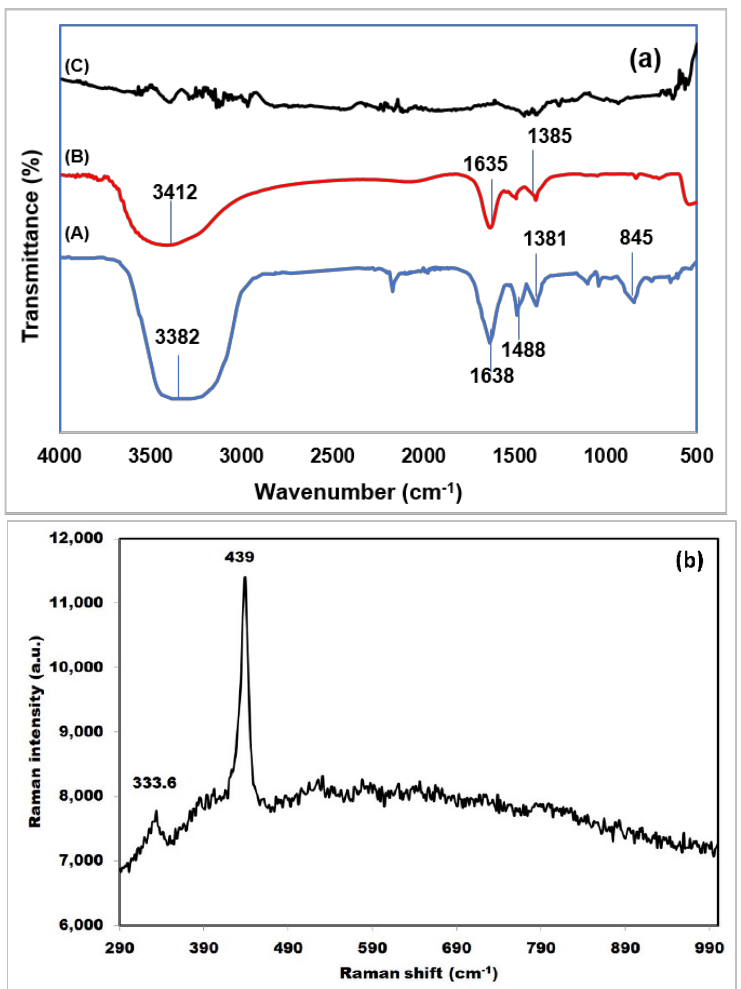
Figure 5. ( a ) FTIR spectrum of P. pyrifolia fruit extract (A), ZnO NS before calcination (B), calcined ZnO NS (C) and Raman spectrum of ZnO nanostructures ( b ).